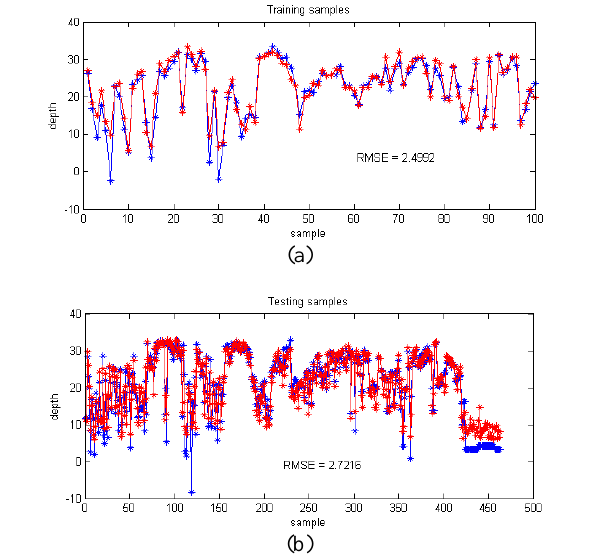
Figure 4. Error assessment of training and testing samples for